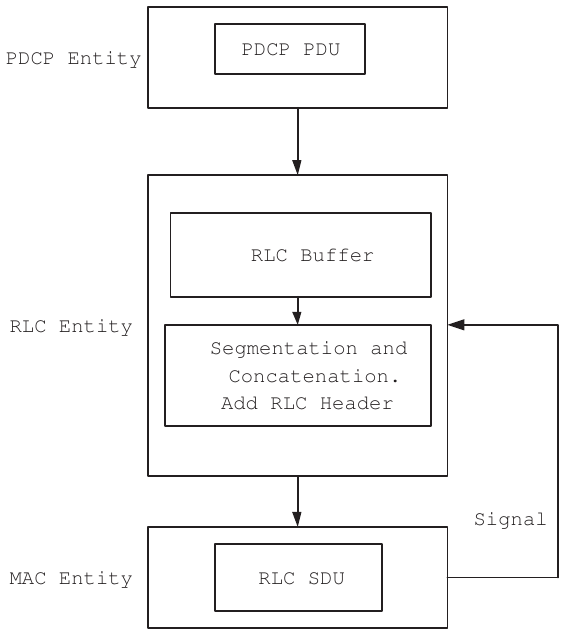
Figure 1. Model of Radio Link Control (RLC) entity in the Long-Term Evolution (LTE)